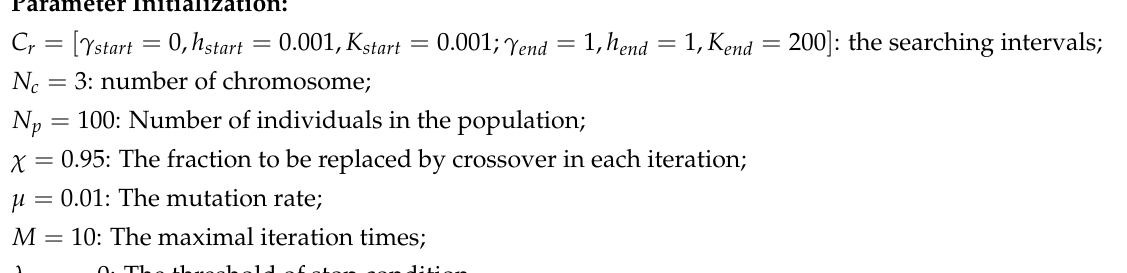
Algorithm 1 Parameter Optimization